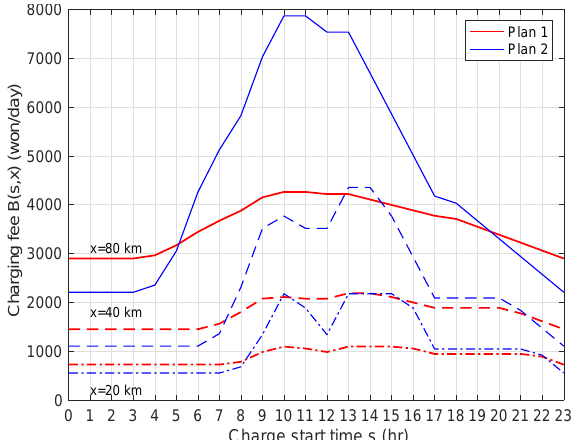
Figure 4. Charging fee B ( s , x ) of (6) when charging with the rate plans of Figure 3 ( α = 5.2 km/kWh, η = 0.95, ¯ ρ = 3 kW, and KRW 1000 is USD